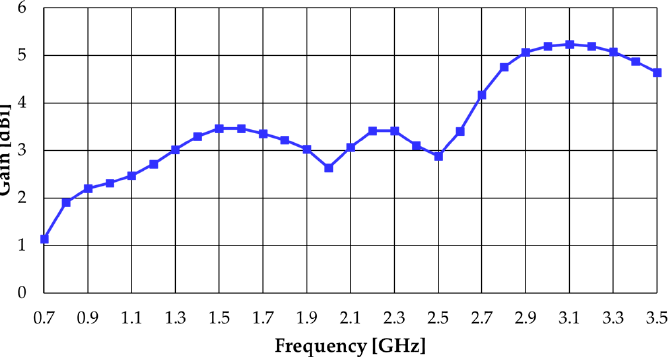
Figure 10. CST simulated far-field 2D radiation pattern results of the modified octagonal monopole. ( a ) H-plane (XY); ( b ) E-plane (XZ); ( c ) E-plane (YZ).